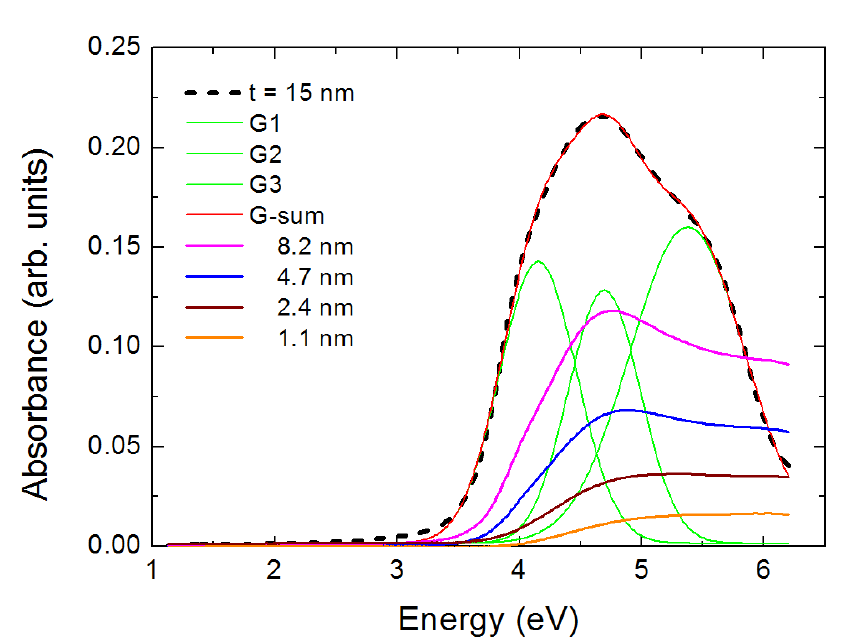
Figure 3. Absorbance spectra for five rutile films; their thickness t is indicated. The absorbance of the thickest film is fitted with the help of three Gaussians G1, G2, G3. As t decreases the spectra present a “blue